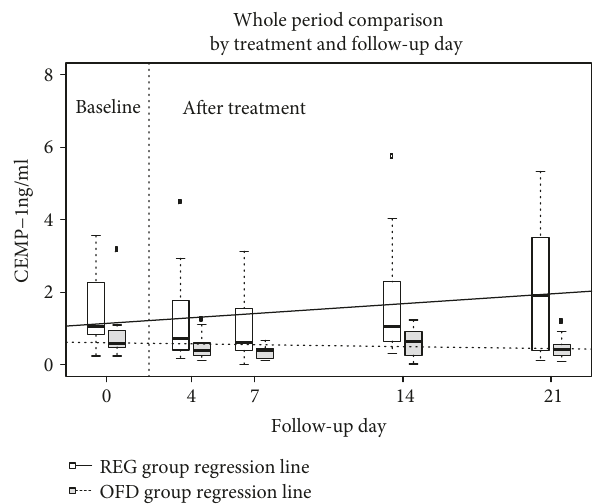
Figure 5: Plot representing distribution of CEMP-1 in ng/ml by treatment and week (baseline is day 0, while days 4 to 21 are after treatment) using box plots. The REG group is white, OFD is grey, the thick black line is the median, the box contains the 1st to the 3rd quartile, and the whiskers are the lowest and highest values within 1.5 times the interquartile range from the box, other values are represented as outliers. The regression lines from the linear mixed model are also plotted (REG, line; OFD, dashed